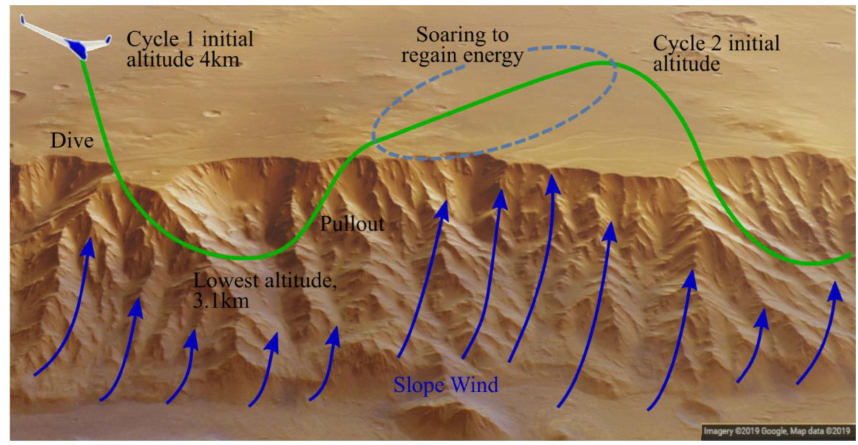
Figure 10. Canyon exploration concept using dive-pullout maneuver followed by static or dynamic soaring. The origin of the frame of reference is placed at the canyon’s ridge with the z-axis pointing downwards, thus the flight height is H = − z . The sailplane dive-pullout flight trajectory was analyzed by splitting the maneuver into dive and climb segments. The dive starts at the time t ds , ends at t de , and the climb lasts from t cs = t de to t ce . The state and control vectors at the end of a dive determine the starting conditions for the next